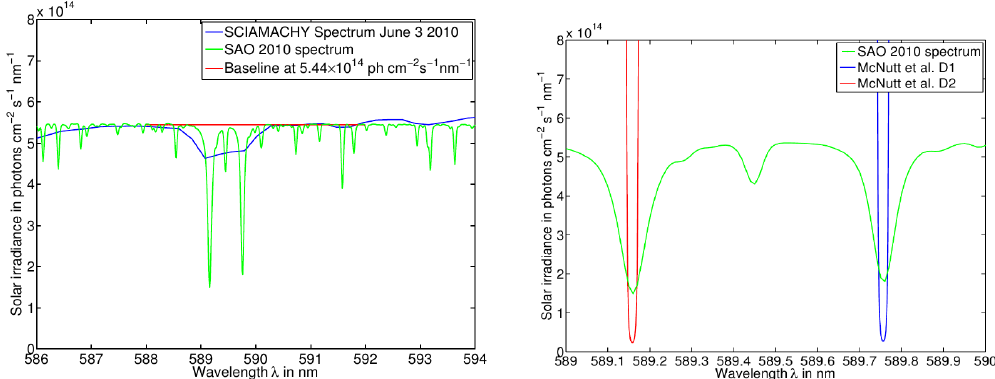
, which agrees for both, is scm 2 nm